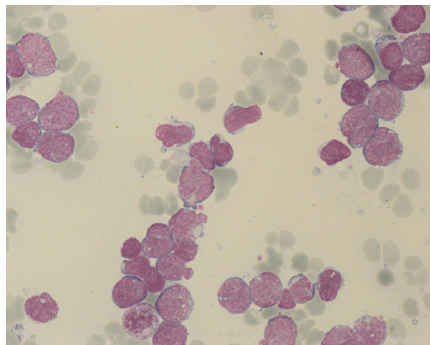
Figure 1: Bone marrow aspirate morphology at diagnosis, showing atypical granular